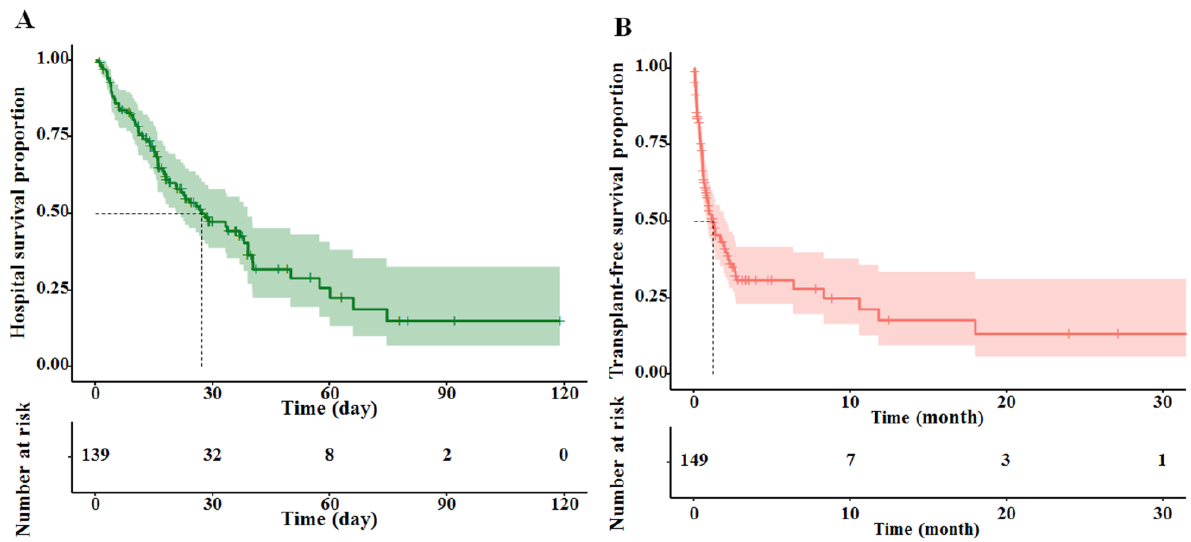
Figure 2. Kaplan–Meier curves demonstrating hospital survival ( A ) and transplant-free survival ( B ) with 95% confidence interval.